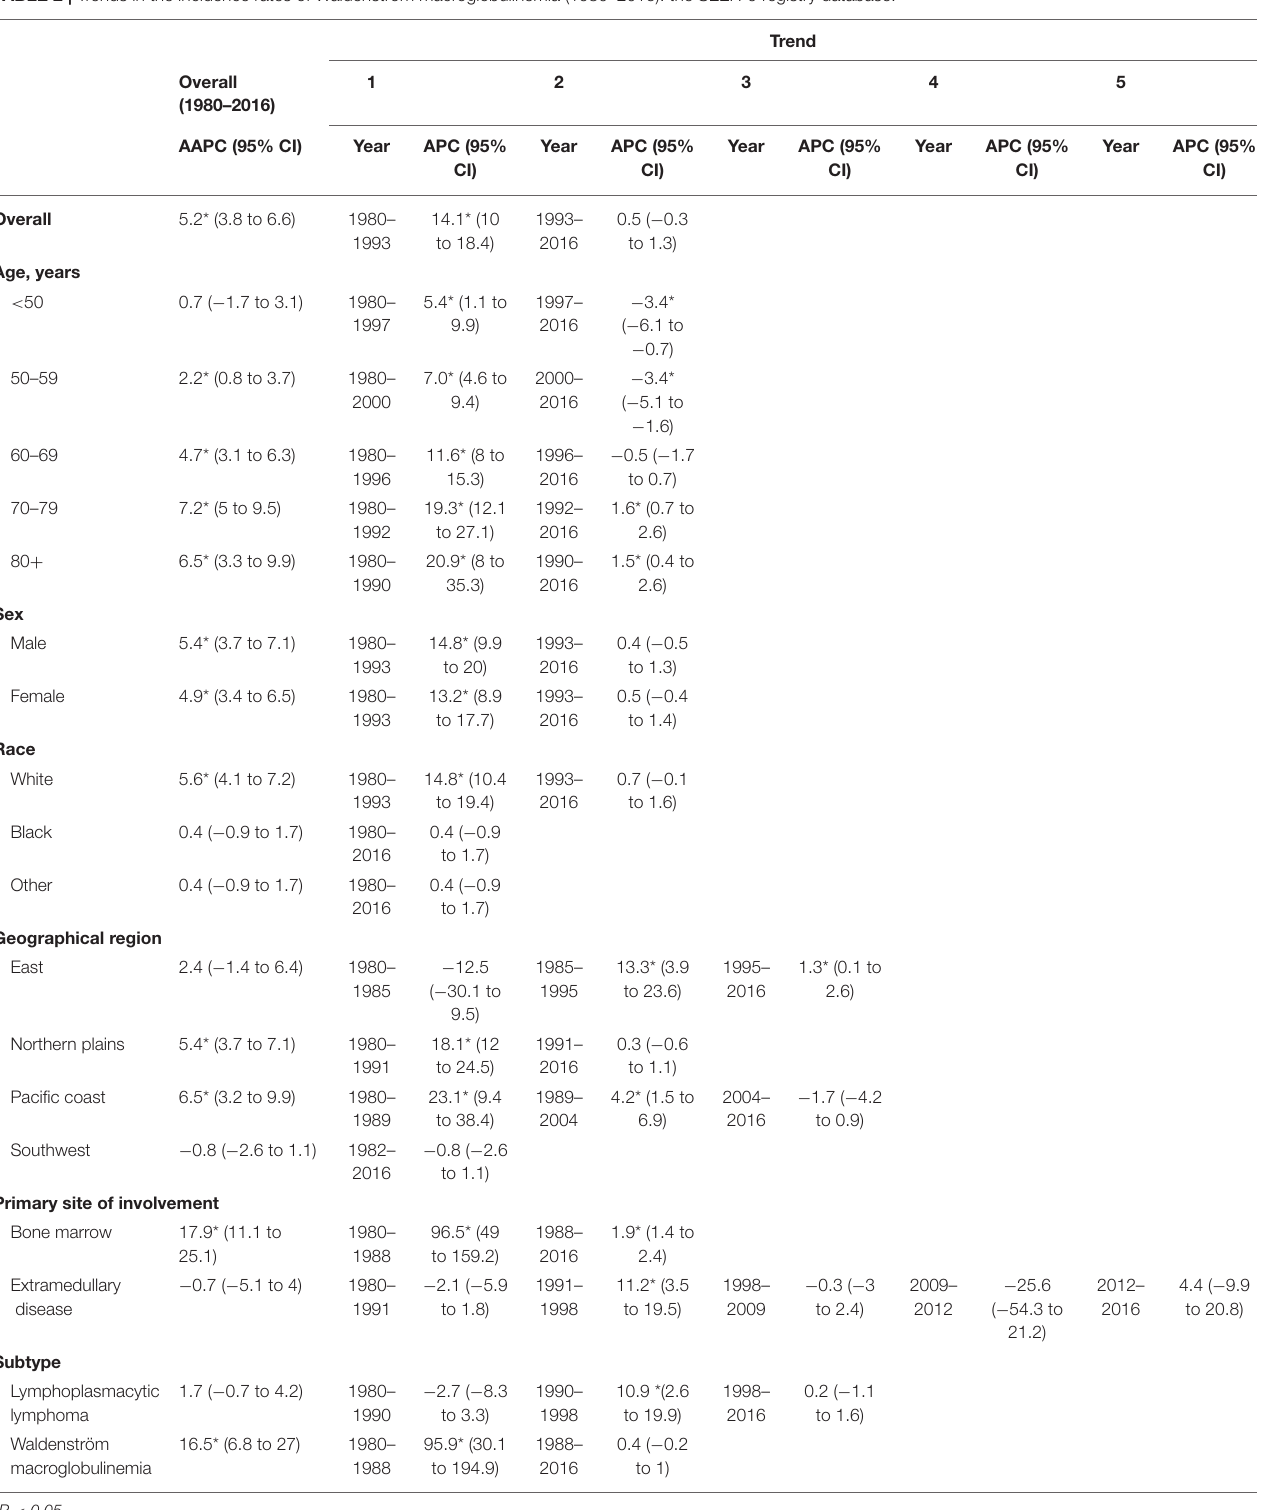
TABLE 2 | Trends in the incidence rates of Waldenström macroglobulinemia (1980–2016): the SEER-9 registry